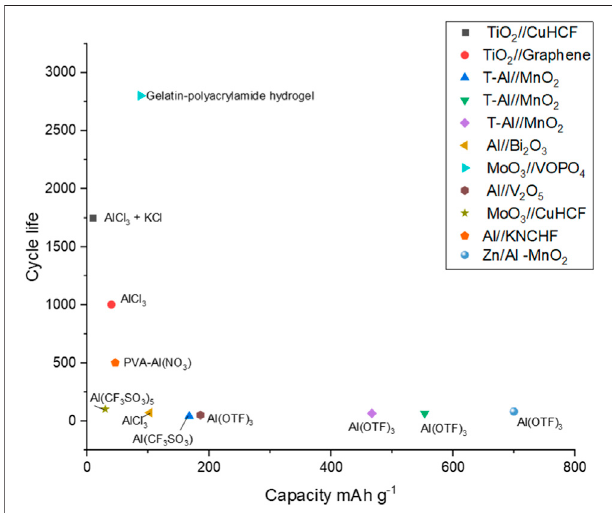
FIGURE 8 | Cycle life plotted against the speci fi c capacity for full cells, with electrolyte information overlaid (Wang et al., 2019; Holland et al., 2018b; Holland 2018; Zhao et al., 2018; He et al., 2019; Wu C.et al.,2019; Yan et al., 2020;Gaoetal.,2020;Wangetal.,2020;Zhaoetal.,2020;Nandietal., 2019; Nandi and Das,